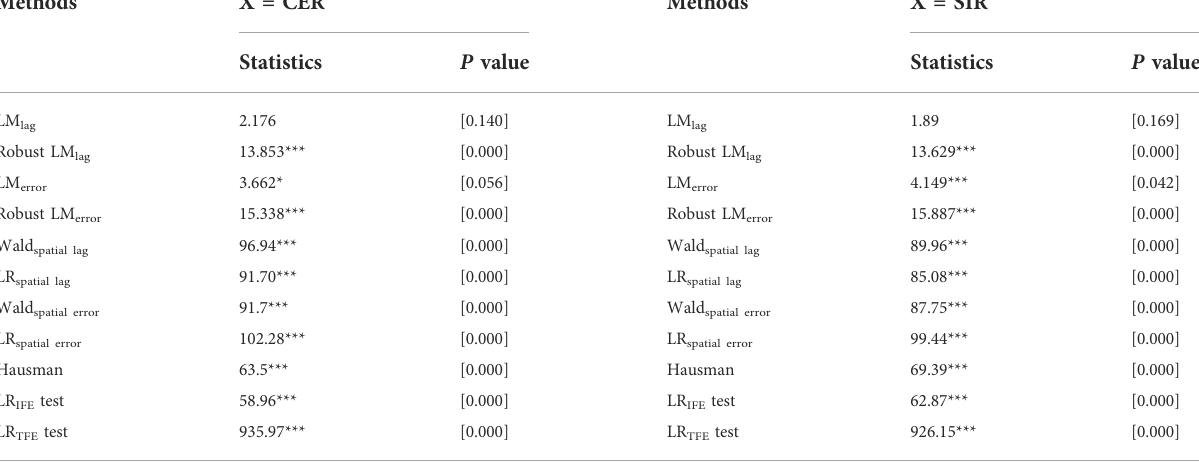
TABLE 3 Spatial model applicability